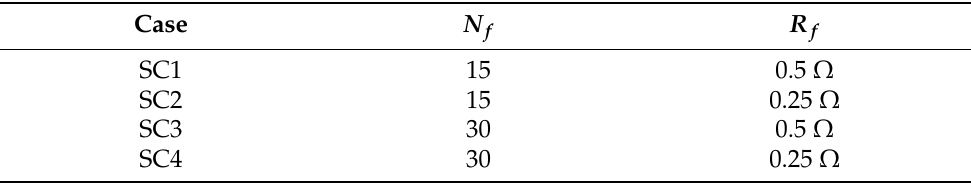
Table 2. Severity levels of TTSC fault.